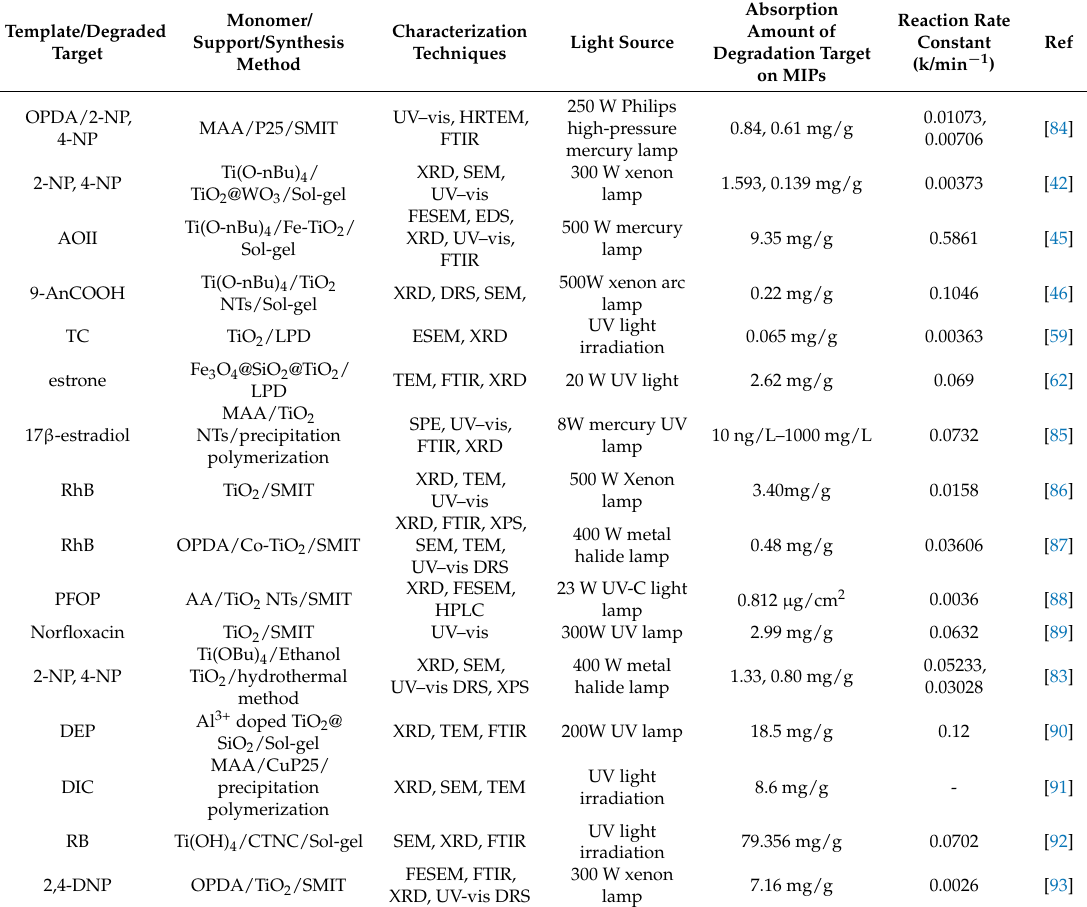
Table 2. Application of MIPs modified TiO 2 nanomaterials for photocatalytic